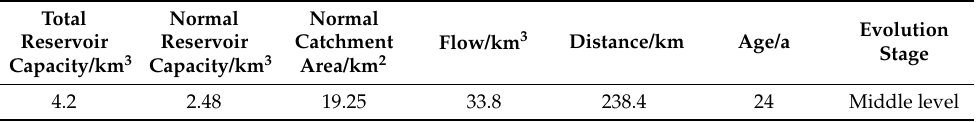
Table 1. Basic parameters at Yelang reservoir.